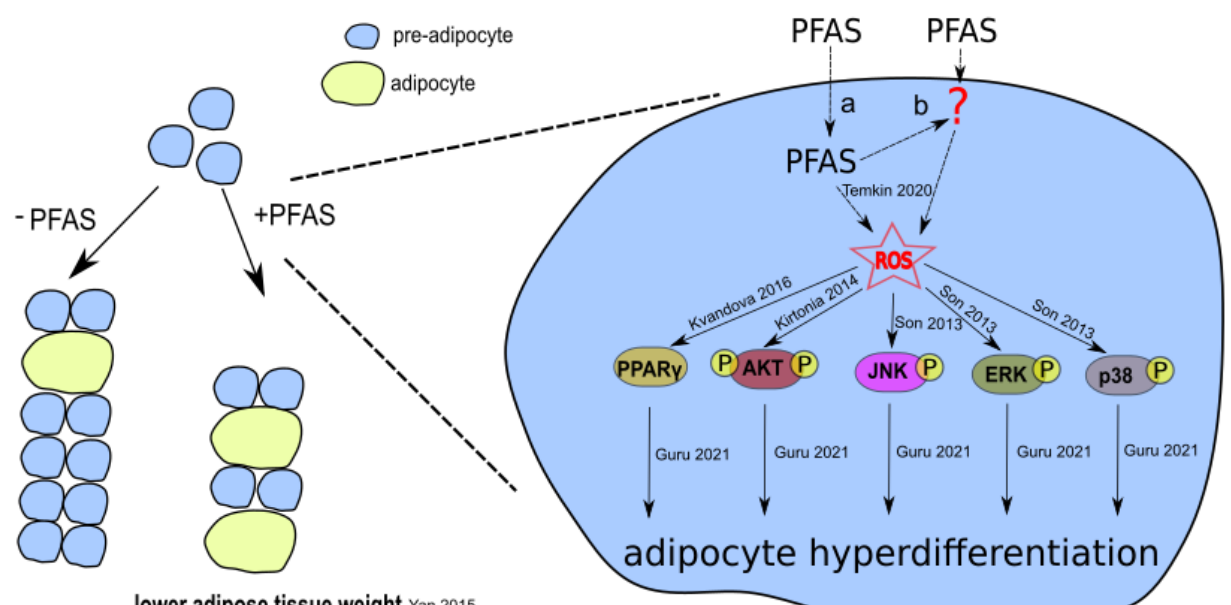
Figure 3. Possible mechanism of PFAS-associated reduction in adipose tissue. PFAS generate ROS directly (a) or indirectly (b). ROS trigger elevated PPARγ expression as well as activation of AKT, JNK, ERK, and p38 by phosphorylation, resulting in hyper-differ- entiation of pre-adipocytes. As a result, fewer proliferating pre-adipocytes remain after PFAS exposure, causing lower adipose tissue weight. Temkin 2020 [164]; Kvandova 2016 [177]; Kirtonia 2020 [176]; Son 2013 [178]; Guru 2021 [174]; Yan 2015 [75]. The proposed mechanism is not related to existing AOPs (AOP-Wiki).